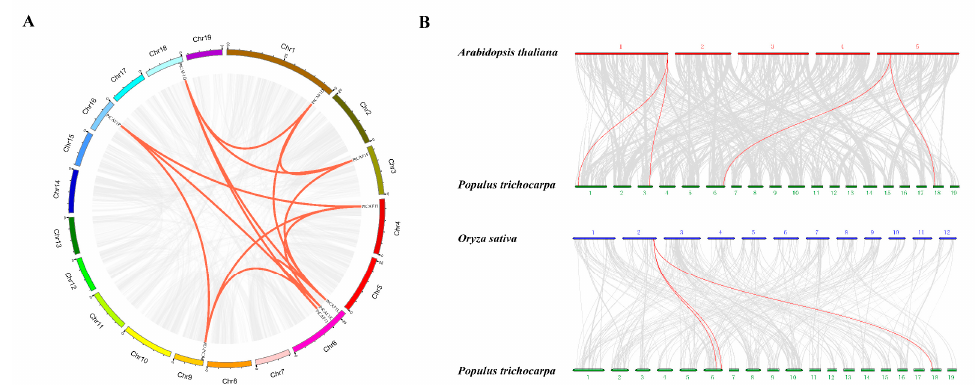
Figure 5. Duplication event analysis of CAF1 genes and comparative synteny analysis among P. trichocarpa , A. thaliana, and O. sativa . Gray lines in the background indicate the collinear blocks within P. trichocarpa and other plant genomes, while red lines highlight syntenic PtCAF1 gene pairs. ( A ) The data were derived from the Plant Genome Duplication Database, and 14 couples of duplicated PtCAF1 genes were anchored to corresponding positions on P. trichocarpa chromosomes using the CIRCOS program. ( B ) Synteny between P. trichocarpa and A. thaliana or between P. trichocarpa and O. sativa was anchored to the corresponding position on specific chromosomes using the CIRCOS program. P. trichocarpa chromosomes are depicted as green segments, and A. thaliana and O. sativa are shown in red and blue, respectively. The size of chromosomes was consistent with the actual pseudo-chromosome size.